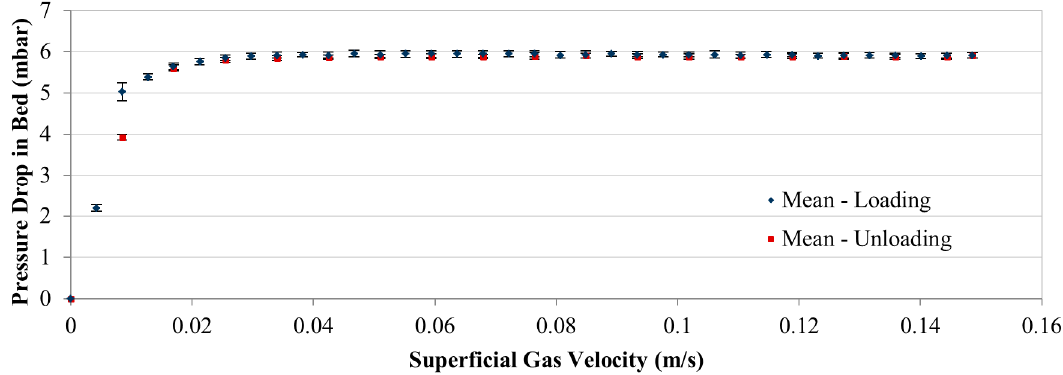
Figure 12. Mean value (symbols) and standard deviation (vertical bars) of ∆ P b ( U sg ) when repeating fluidization tests for fluidization loading and unloading of fine particle bed (CALCIT MVT-100).